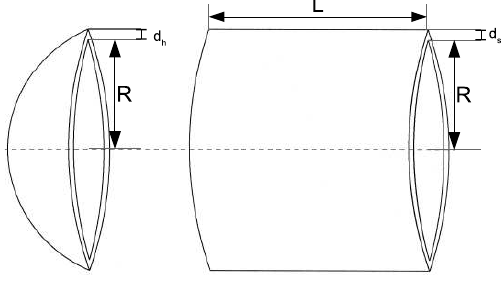
Figure 8. Pressure vessel design problem. Table 1. Benchmark functions: dimensions and